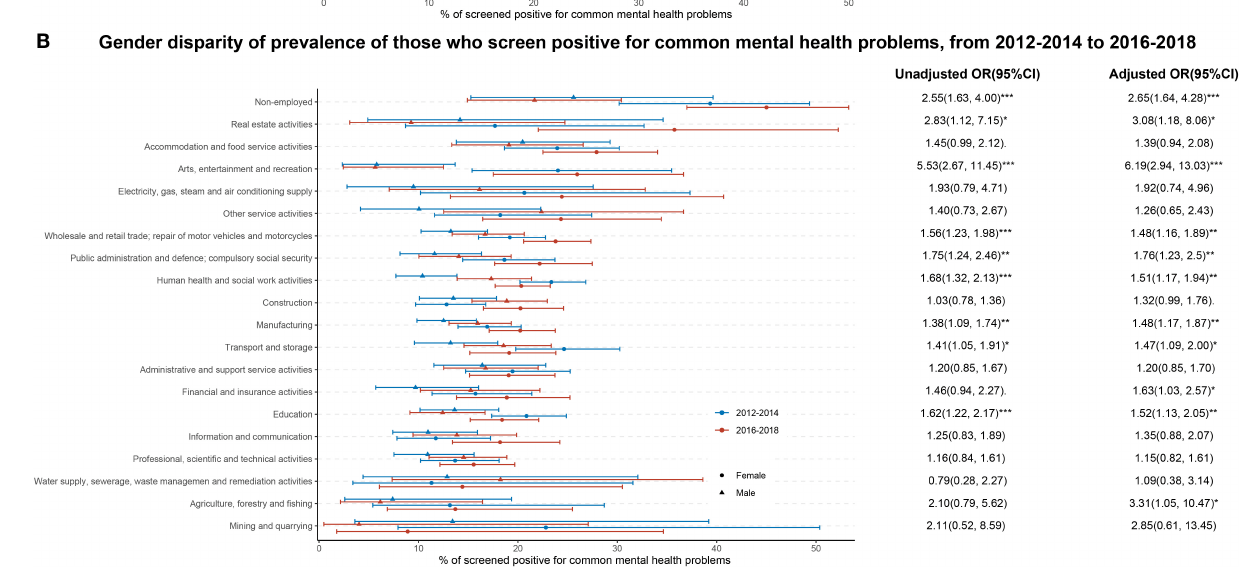
FIGURE2 Prevalence and gender dispraise of those who had common mental health problems in the UK, by industrial classification, from 2012–2014 to 2016–2018. Shown are the prevalence and its 95% confidence interval (CI) of populations who screen positive for common mental health problems. The odd ratios (OR) and its 95 CI% were estimated from weighted logistic with depression (yes or no) as the dependent variable and survey period [with 2012–2014 as the reference, in (A) ] or gender [with male as the reference, in (B) ] as the key predictor. Adjusted OR controlled for age, gender (A) or study period (B) , marital status, education attained, index of multiple deprivations, and long-standing physical illness. * < 0.05, ** < 0.01, *** < 0.001.